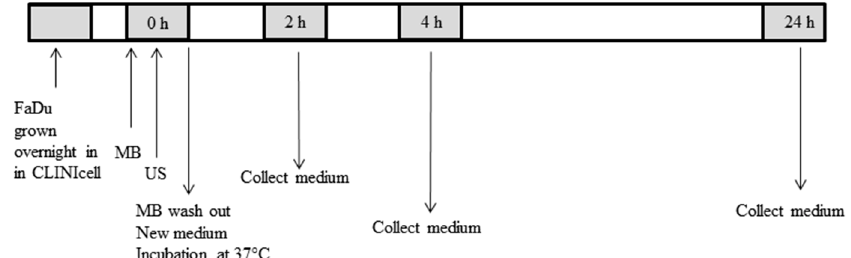
Figure 6. Timeline of microbubbles-assisted ultrasound (USMB) experiment of FaDu cells. First, medium containing microbubbles (MB) were added into the FaDu cells grown overnight in the cell culture chamber, and then ultrasound (US) was applied. Medium was directly removed after USMB and cells were washed once. Cells received new medium and incubated for 2, 4, and 24 h. At these time points, cells and conditioned medium were collected.